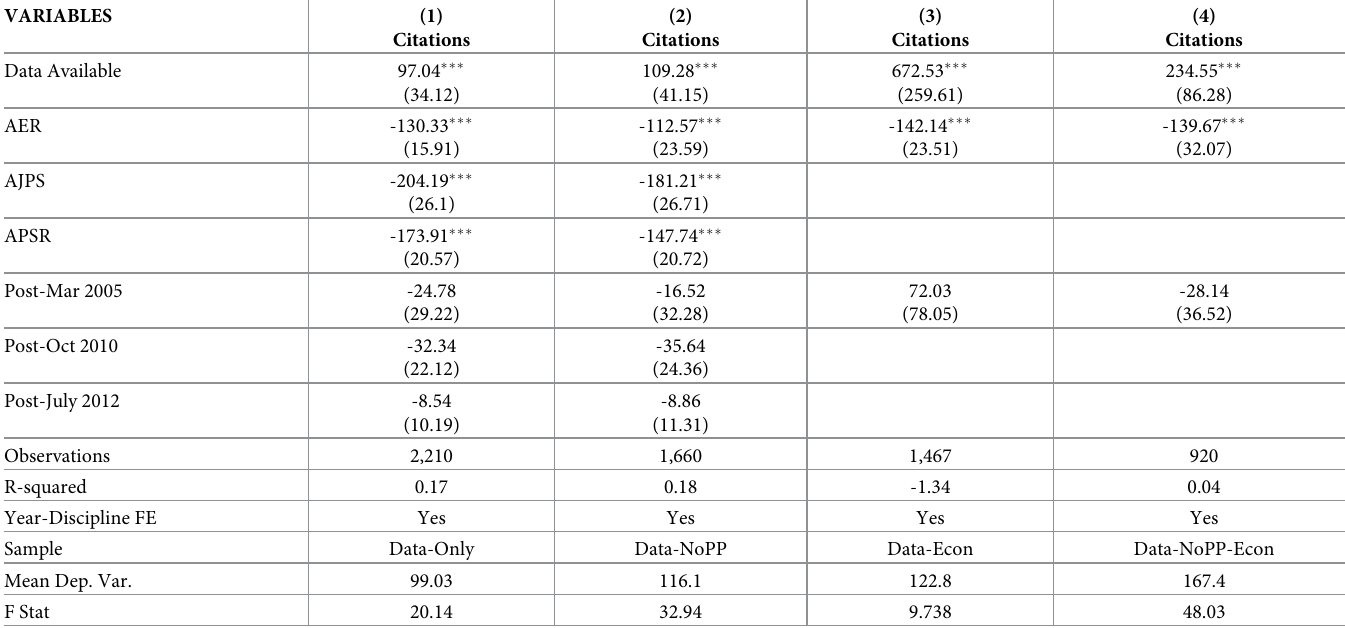
Table 3. 2SLS estimate of data sharing and citations.